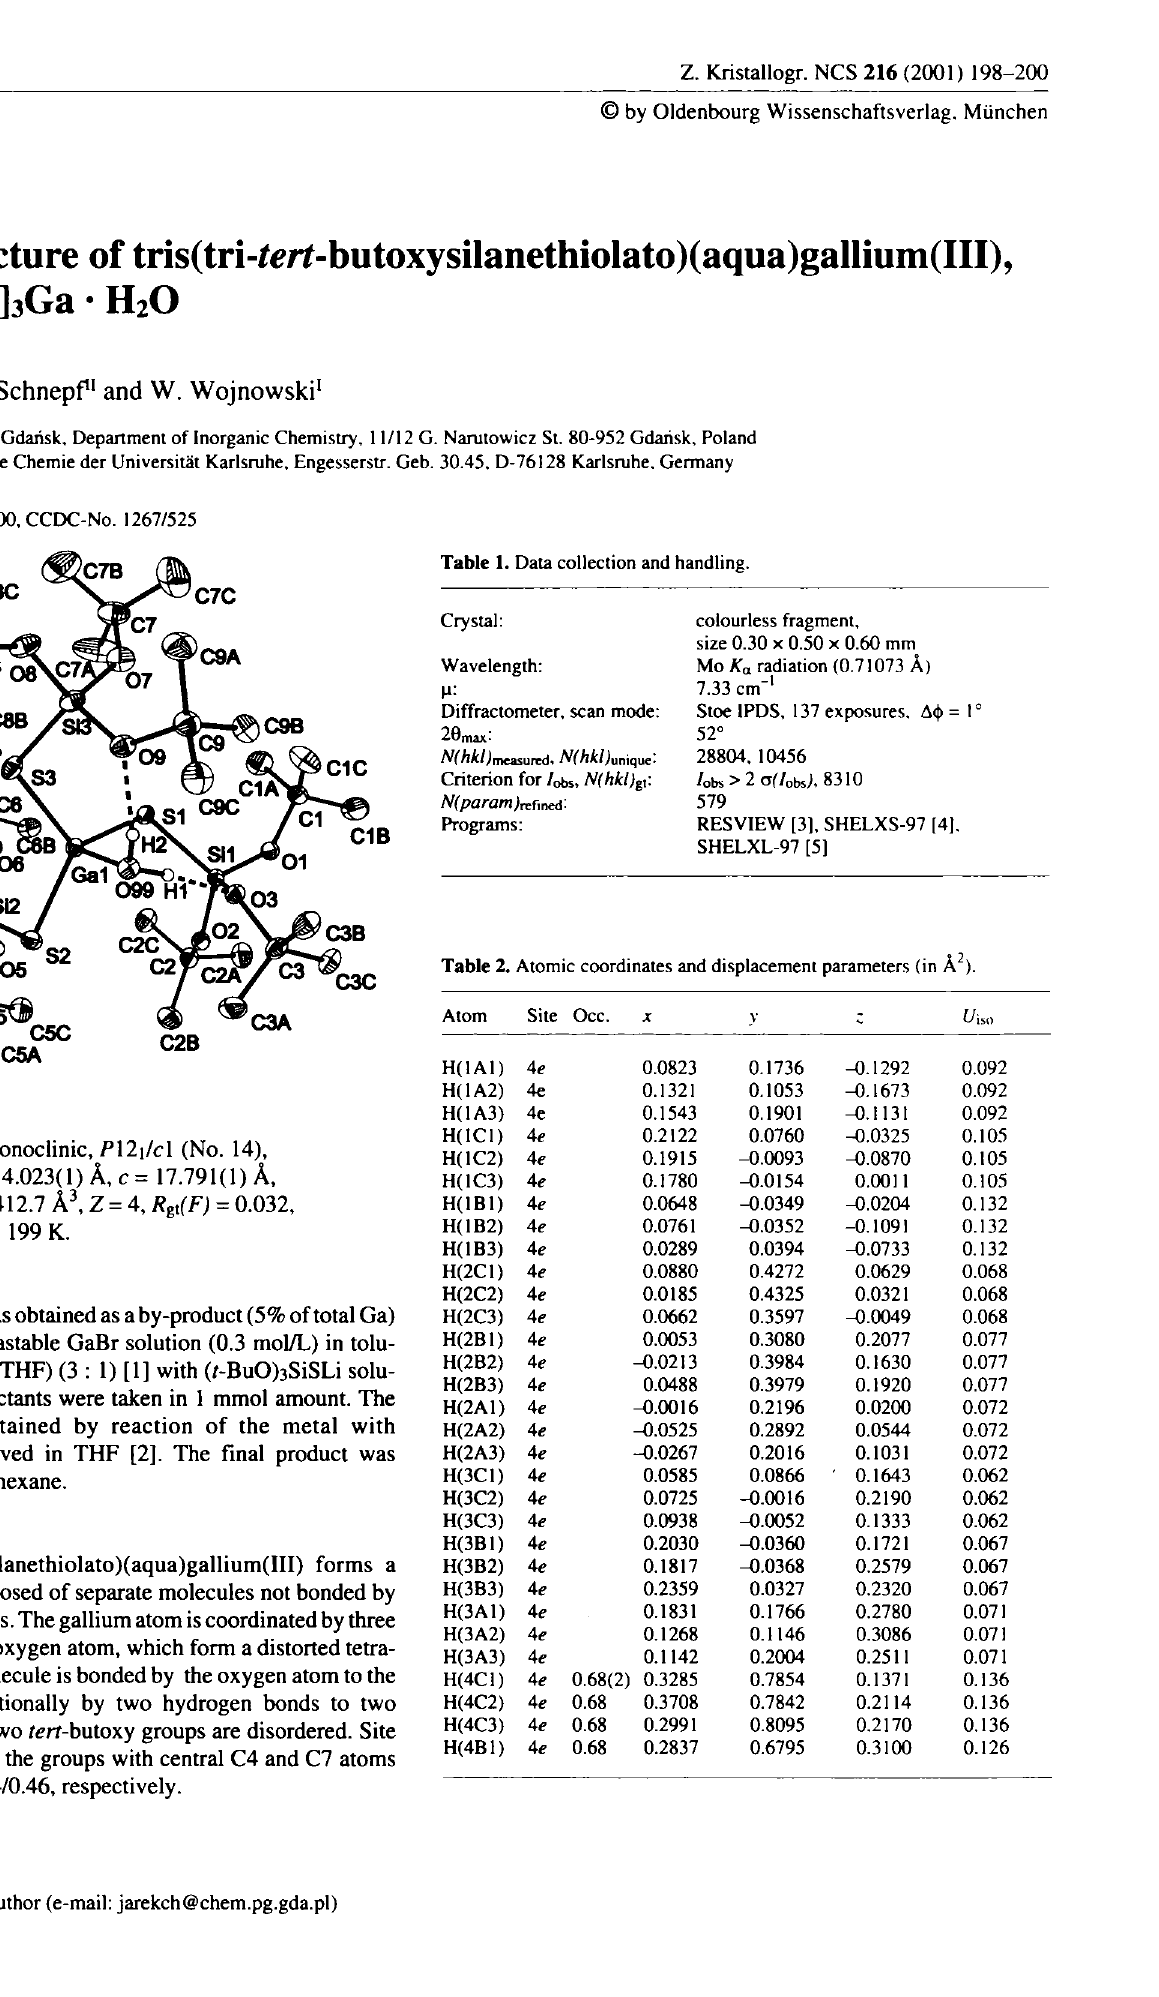
Table 1. Data collection and handling.